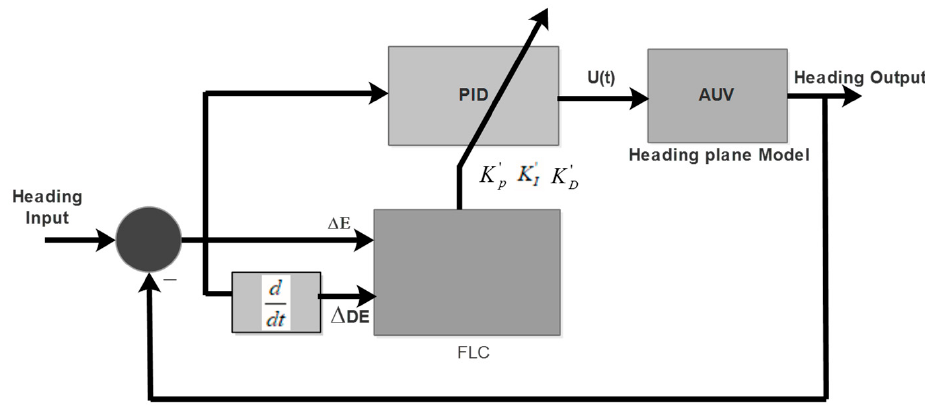
Figure 10. Block diagram of self-tuning fuzzy-PID.